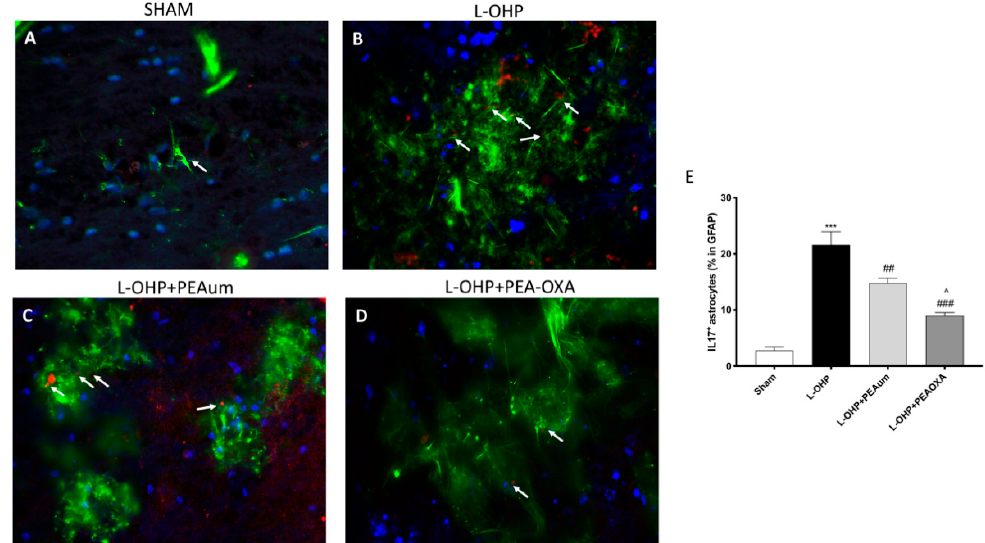
Figure 5. Effect of PEA-OXA on GFAP and IL-17 expression. The immunofluorescence staining for GFAP (green) and IL-17 (red) was made in the lumbar spinal cord sections. Considerable astrogliosis with production of IL17 was present in L-OHP panels ( B , E ), compared to the sham group ( A , E ). The treatment with PEA-OXA did not show any significant immunoreactivity of IL-17 in astrocytes ( D , E ), much more then PEAum ( C , E ). Scale bar = 20 µ m (particle). Data are means ± SEM from n = 10 mice/group. Counting of colocalized cells confirmed our data ( E ). The colocalization image was analyzed with image J software. *** p < 0.001 vs. sham; ## p < 0.01 and ### p < 0.001 vs. L-OHP; ˆ p < 0.05 vs. PEAum.